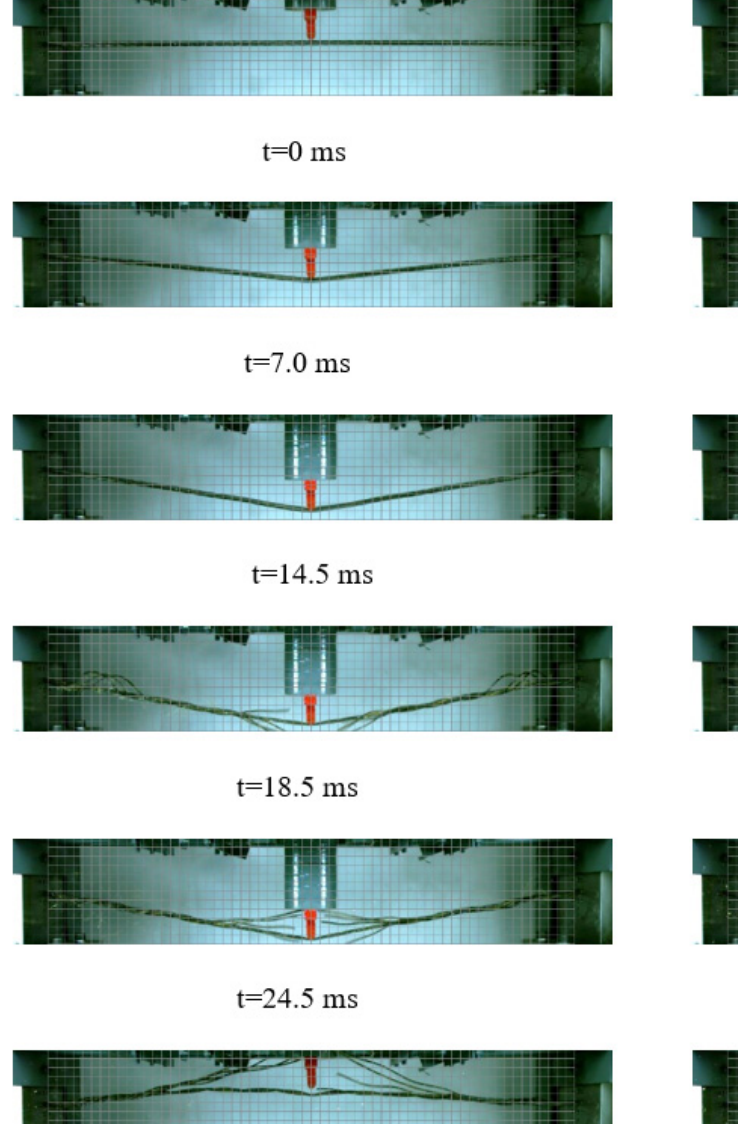
Figure 9. High − speed photographs of strand collisions for the working cases of µ p = 0.298 and V 0 = 12.55 m/s.